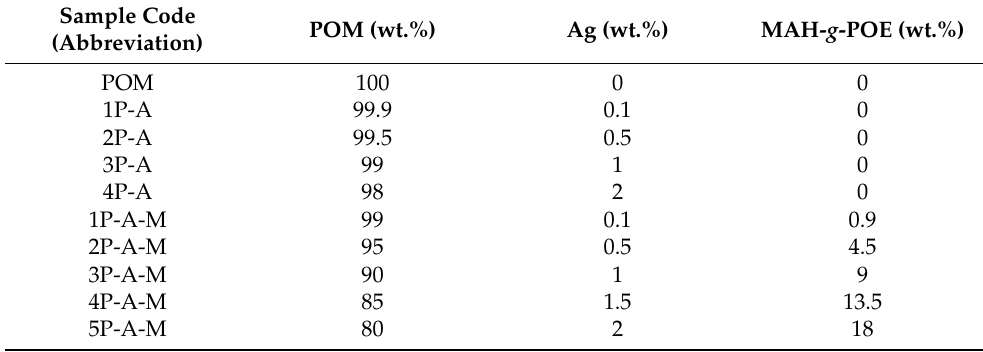
Figure 1. Synthesis procedure of POM/Ag/MAH- g -POE nanocomposites. Table 1. Formulations of the